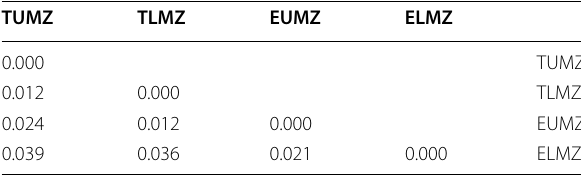
Table 5 Nei unbiased genetic distance for pairwise population matrix of rhizobia populations trapped from the field in TUMZ, TLMZ, EUMZ, and ELMZ in Embu and Tharaka-Nithi Counties